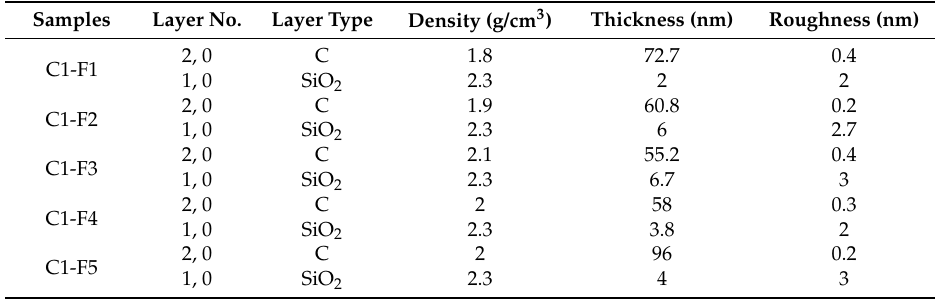
Table 2. Results obtained from simulation of XRR patterns in case of a set of carbon films synthesized by PLD in conditions depicted in Table